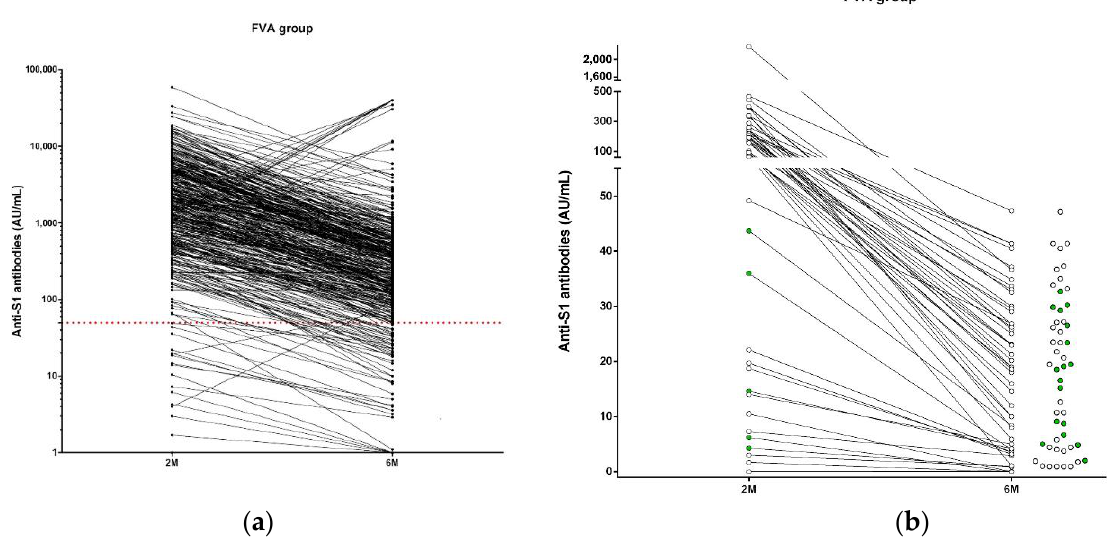
Figure 3. Comparison of anti-S1 antibody levels and cellular immunity after two and six months of BNT162b2 full vaccination in nursing home residents (NHR) included in Full Vaccination Assessment (FVA) group. The level of anti-S1 antibodies was compared in NHR at two and six months after full vaccination in the FVA group. The red line shows the anti-S1 levels at 50 AU/mL, subjects with anti-S1 values below this line were identified as seronegative ( a ). All seronegative NHR after six months of vaccination were assessed for cellular immunity; the green circles show positive specific cellular immunity whereas the white circles show those without a cellular-specific response to vaccination ( b